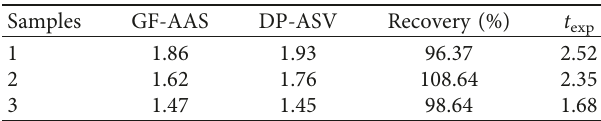
Table 3: Pb(II) content in water samples identified by the DP-ASV method (using the CPE modified with Bi 2 O 3 using CNTs) and the GF-AAS